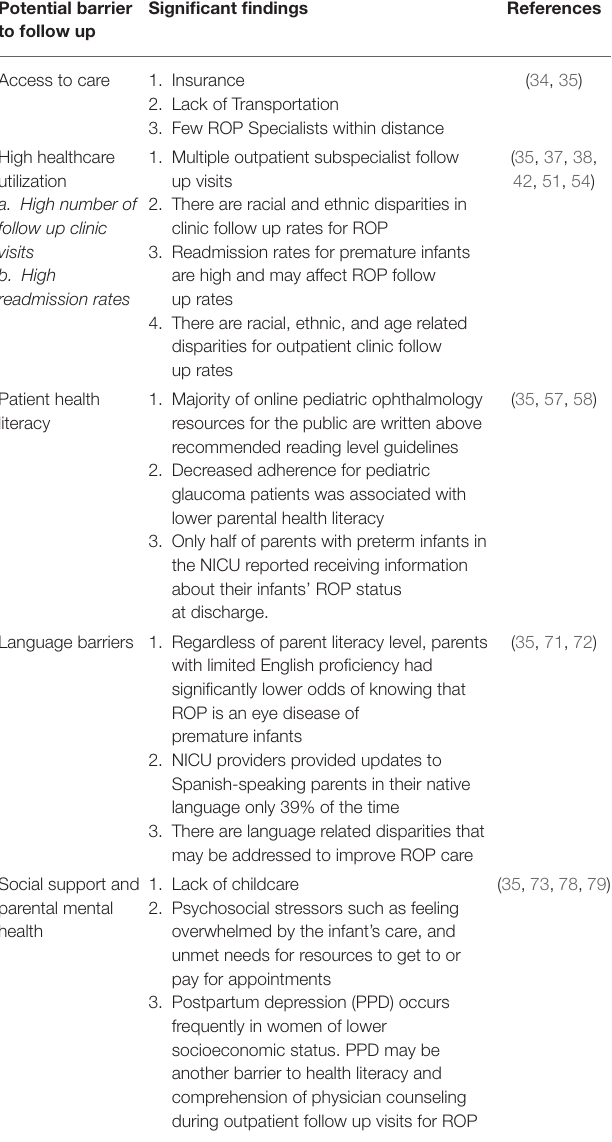
TABLE 1 | Potential barriers to outpatient ROP follow up. Potential barrier to follow up